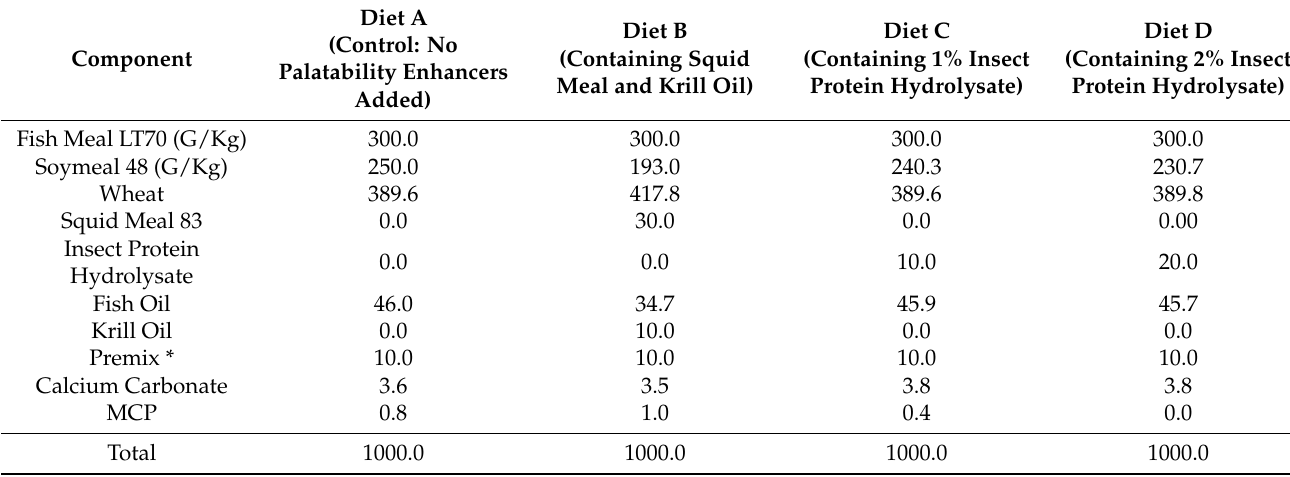
Table 6. Ingredient composition of the basal and experimental